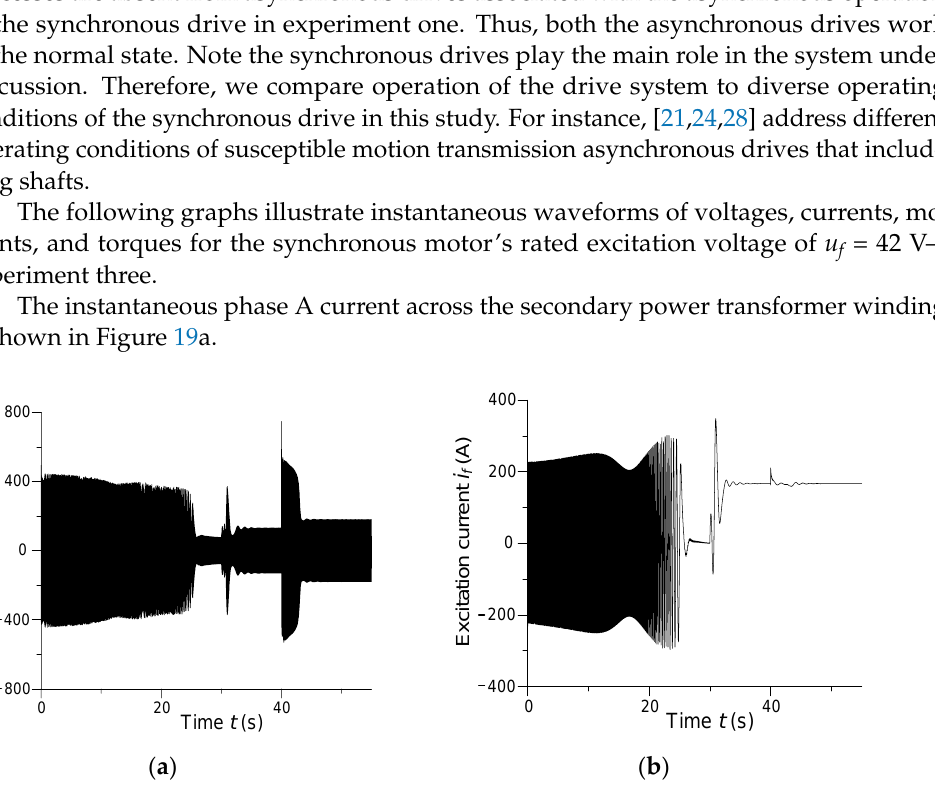
Figure 19. Instantaneous waveforms of: ( a ) phase A current across the secondary power transformer winding; and ( b ) excitation current of the synchronous